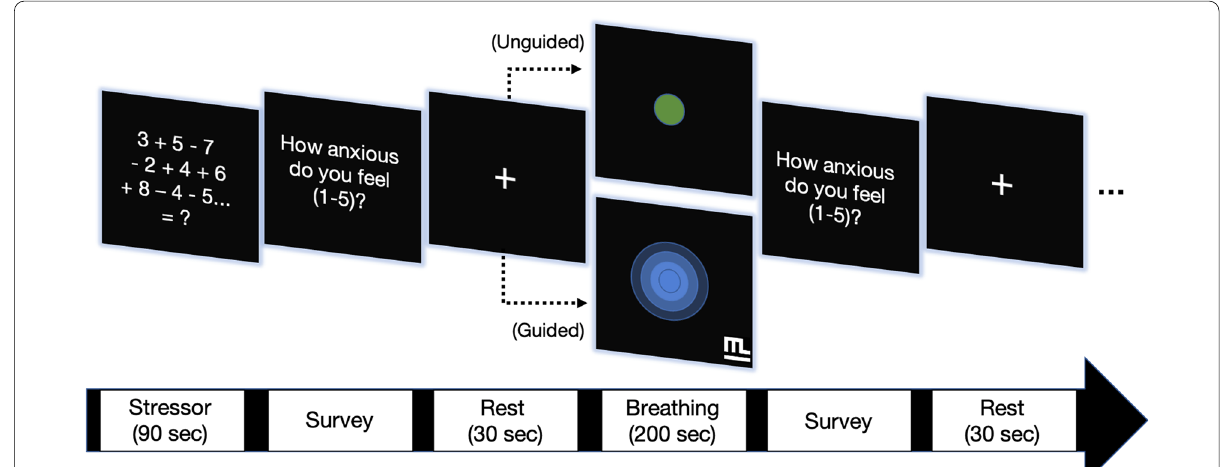
Fig. 1 Experimental design of the procedure. Participants performed four blocks, each consisting of a mental arithmetic task followed by an anxiety self‑report, a period of rest, either guided breathing entrainment or unguided breathing , a second anxiety self‑report and lastly another rest